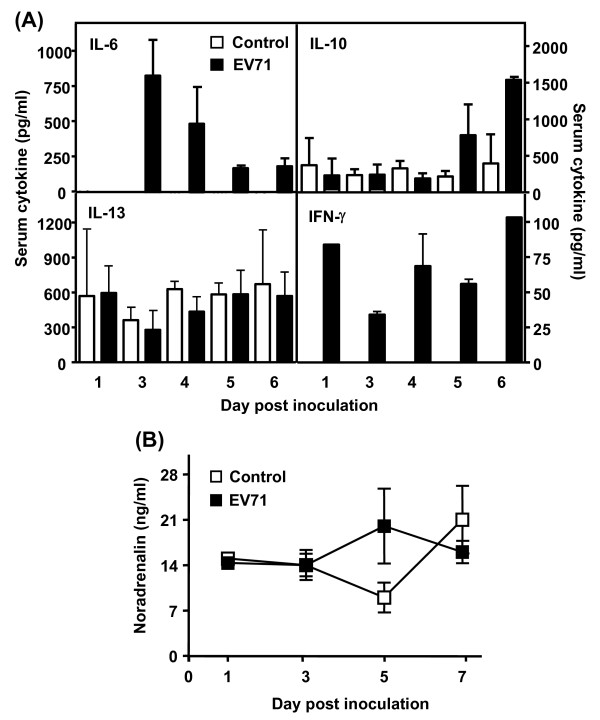
Intracranial inoculation of EV71 transiently increased proinflammatory cytokines in mice, but not noradreanline. Seven-day-old ICR mice (n = 24) were intracranially inoculated with or without EV71/MP4 strain (4 x 105 PFU/mouse). Serum or plasma samples were collected at indicated post-inoculation time points. Concentrations of IL-6, IL-10, IL-13, and IFN-γ (A) and noradrenaline (B) were determined. Data represent means ± S.E.M.